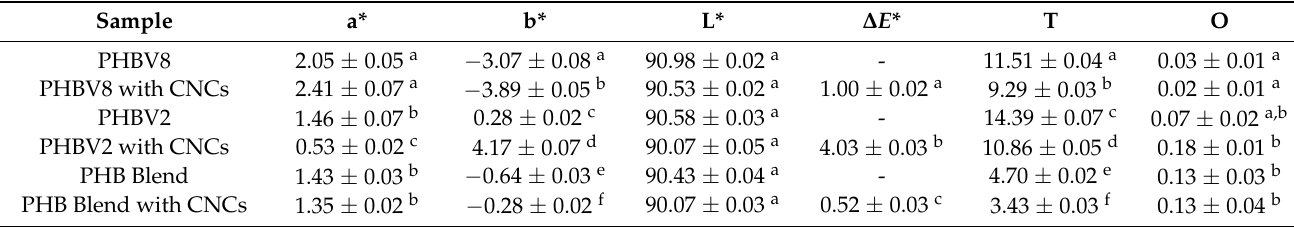
Table 1. Optical properties of the multilayer films of poly(3-hydroxybutyrate- co -3-hydroxyvalerate) (PHBV) containing 8 mol.% (PHBV8) and 2 mol.% 3-hydroxyvalerate (PHBV2) and poly(3-hydroxybutyrate) with poly(butylene adipate- co - terephthalate) blend (PHB Blend), with and without cellulose nanocrystals (CNCs).